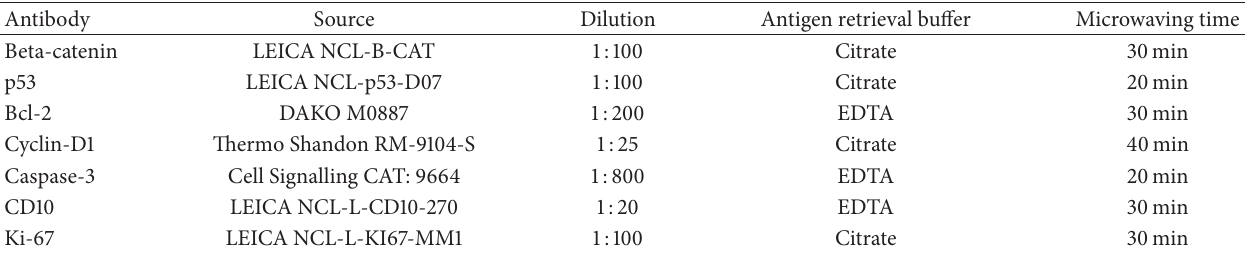
Table 1: Primary antibody sources, dilution, and antigen retrieval buffers and